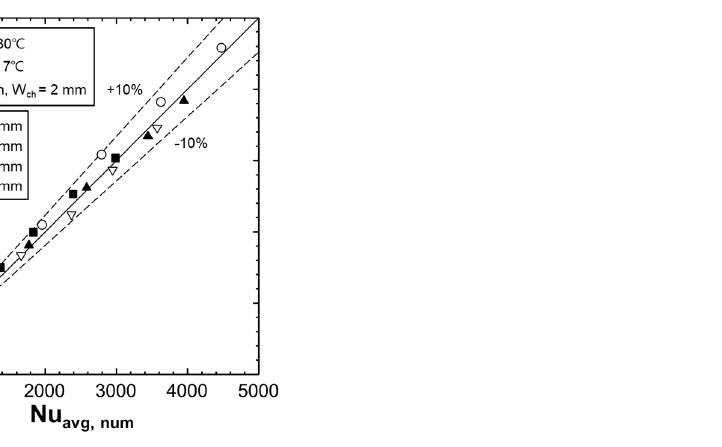
Figure 5. Comparison between experimentally measured and numerically calculated average Nusselt number.